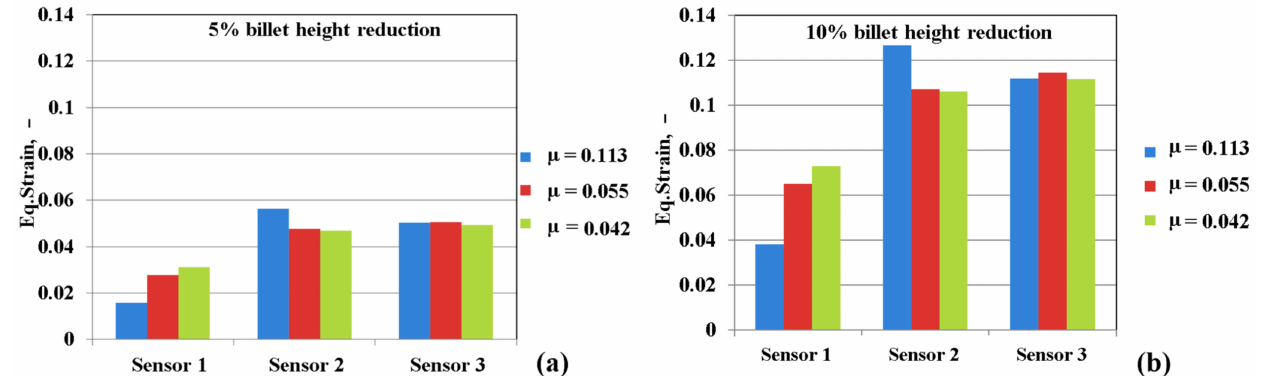
Figure 21. Influence of sensor positions on equivalent strain distribution for different lubrication